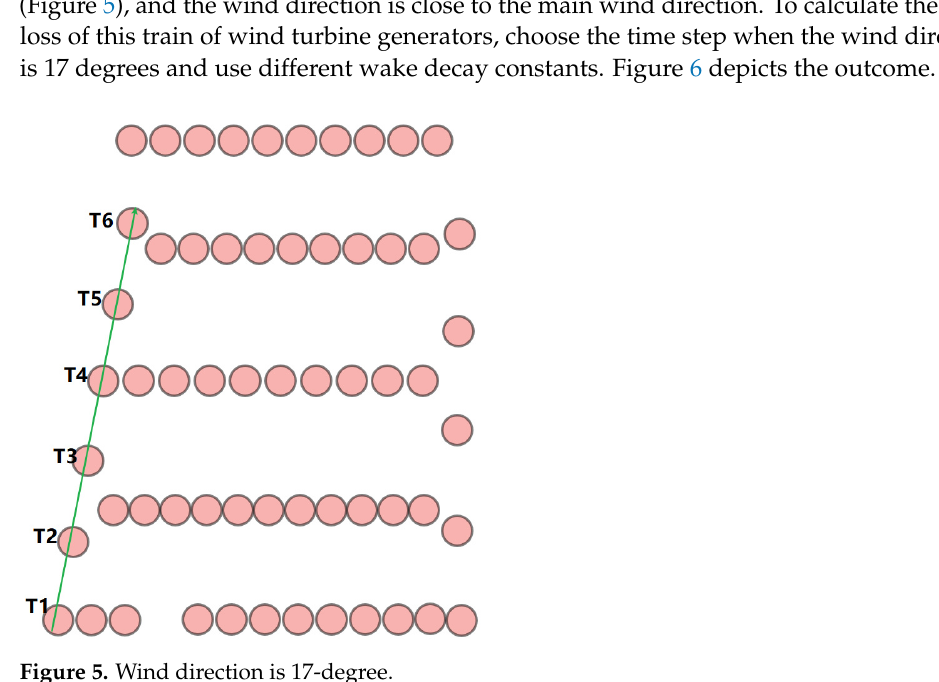
Figure 4. Simulated wake loss for each sector.